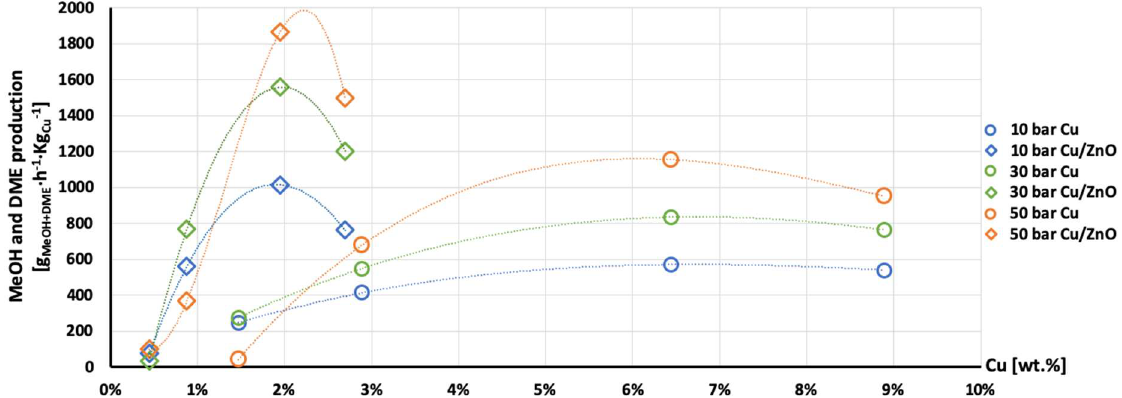
Figure 13. Production of the MeOH and DME per gram of Cu as a function of Cu wt. % content in AlNFs-Cu (circle dots) and AlNFs-1Cu2.3Zn (rhombic dots) catalysts at pressures of 10 (blue), 30 (green), and 50 (orange) bar at temperature 300 °C.